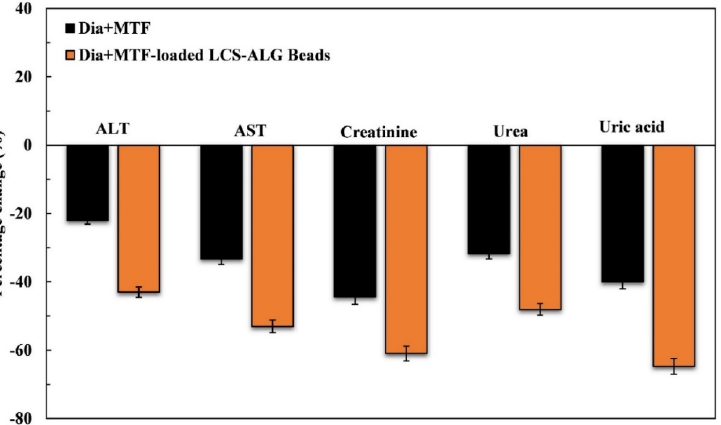
Figure 12. Percentage changes in the biochemical parameters examined in Dia + MTF and MTF- loaded LCS-ALG bead groups relative to the Dia group at the end of the treatment period (29 days). Kidney Function